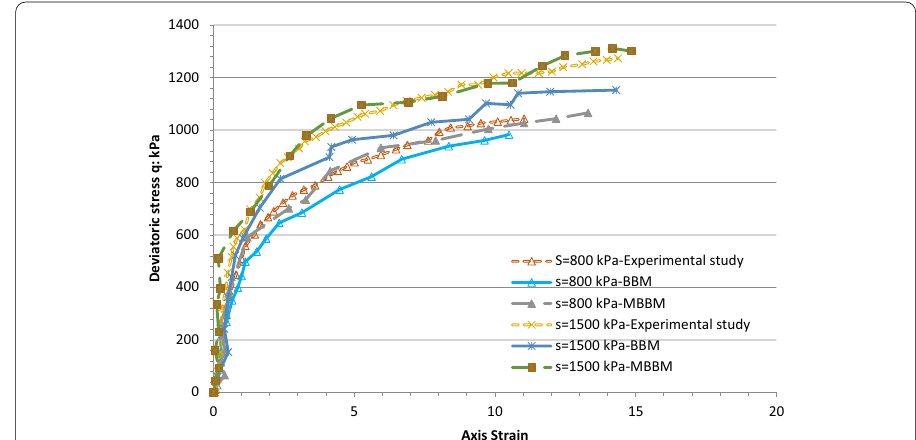
Fig. 21 Comparative curves among experimental, BBM and MBBM for stress–strain and volume change at confining pressure of 400